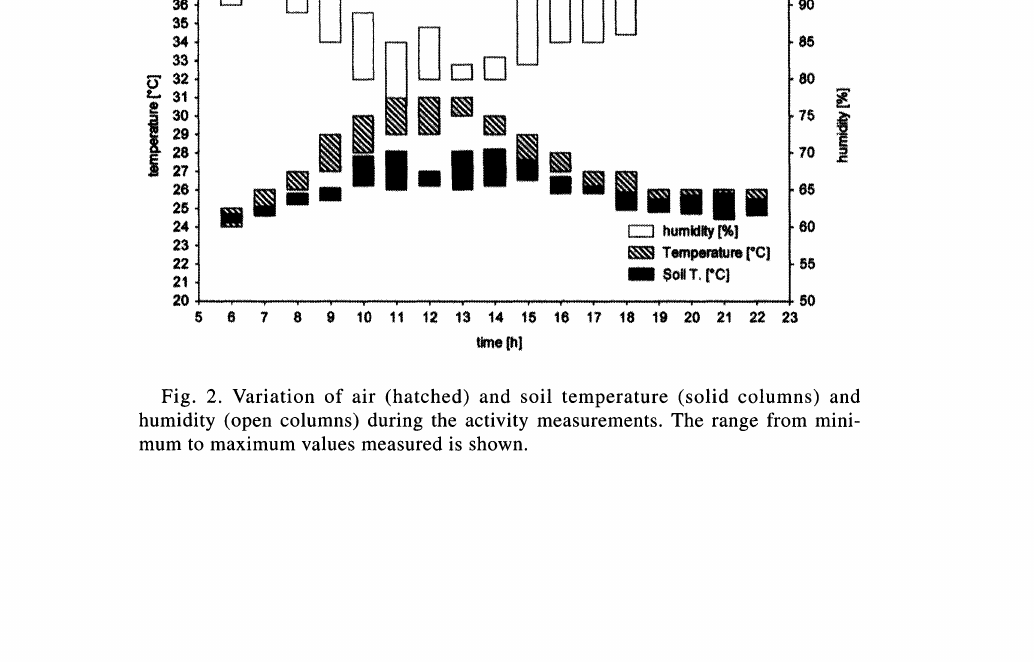
Fig. 2. Variation of air (hatched) and soil temperature (solid columns) and humidity (open columns) during the activity measurements. The range from mini- mum to maximum values measured is